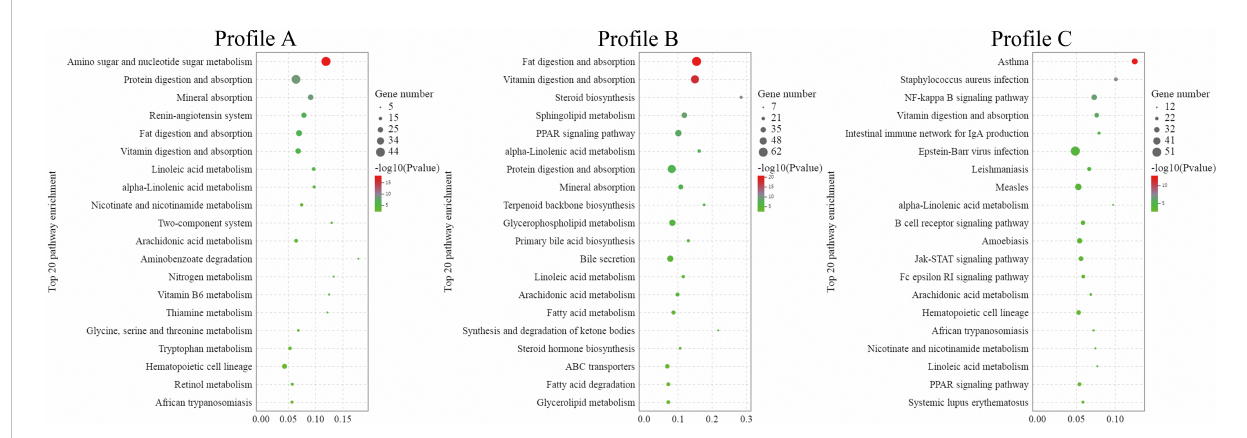
FIGURE 4 The top 20 differentially signi fi cant enrichment pathways in KEGG enrichment analysis of DEGs (n =